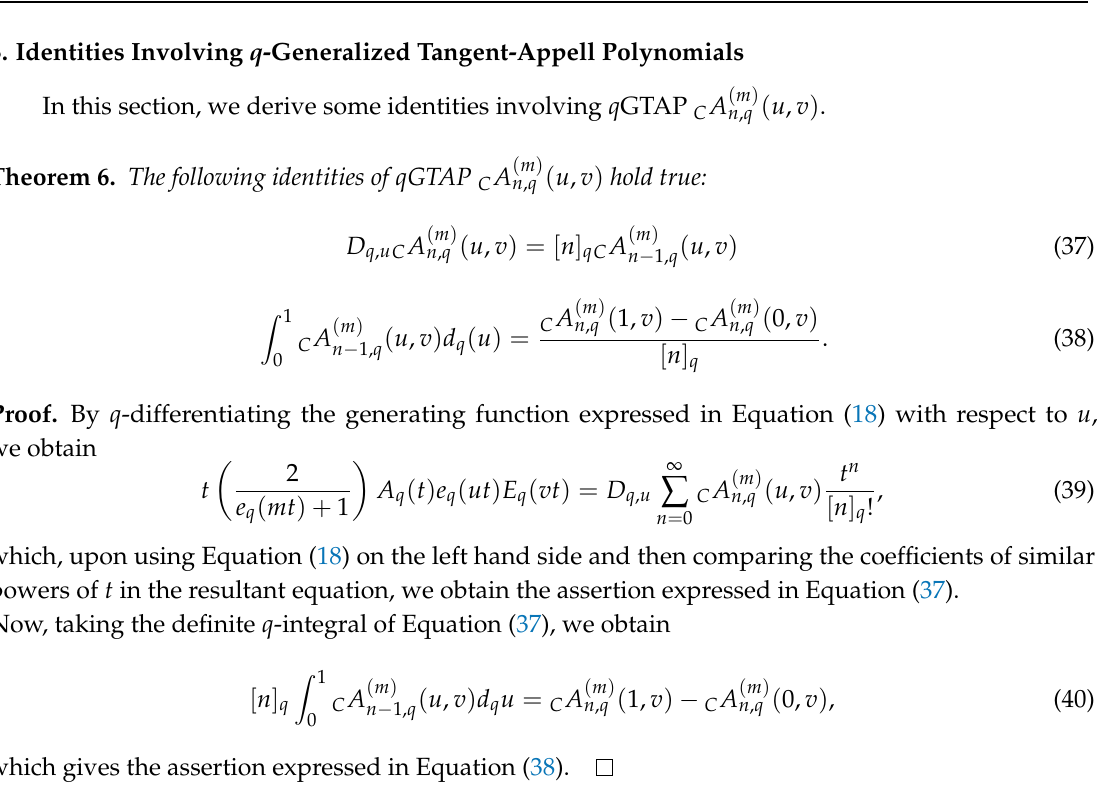
Table 3. Results for q GTBP C B